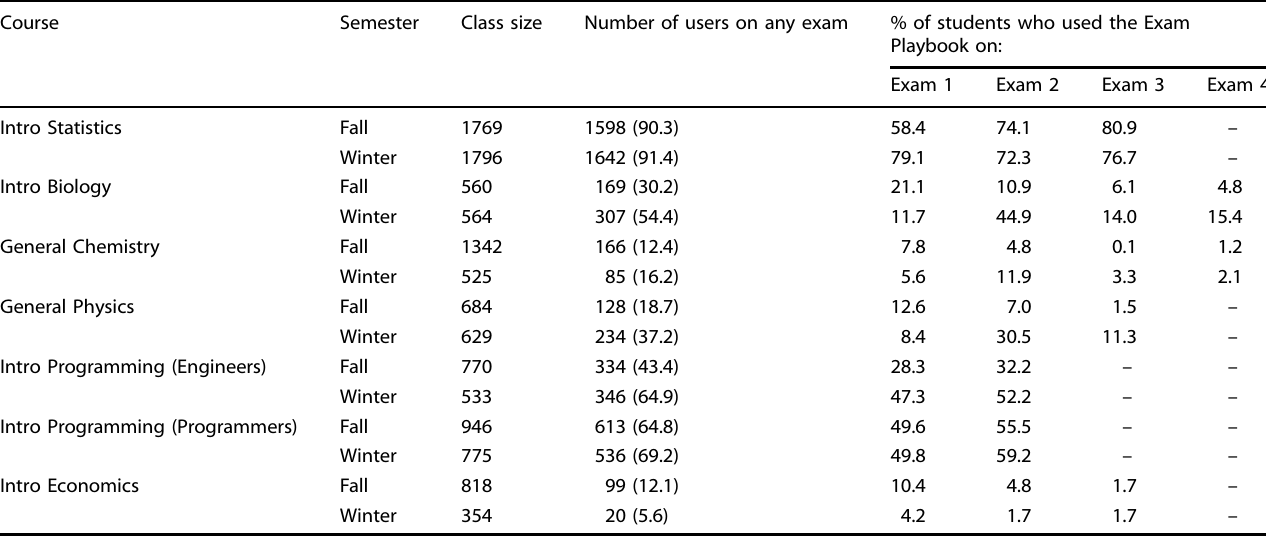
Table 1. Breakdown of the usage of exam